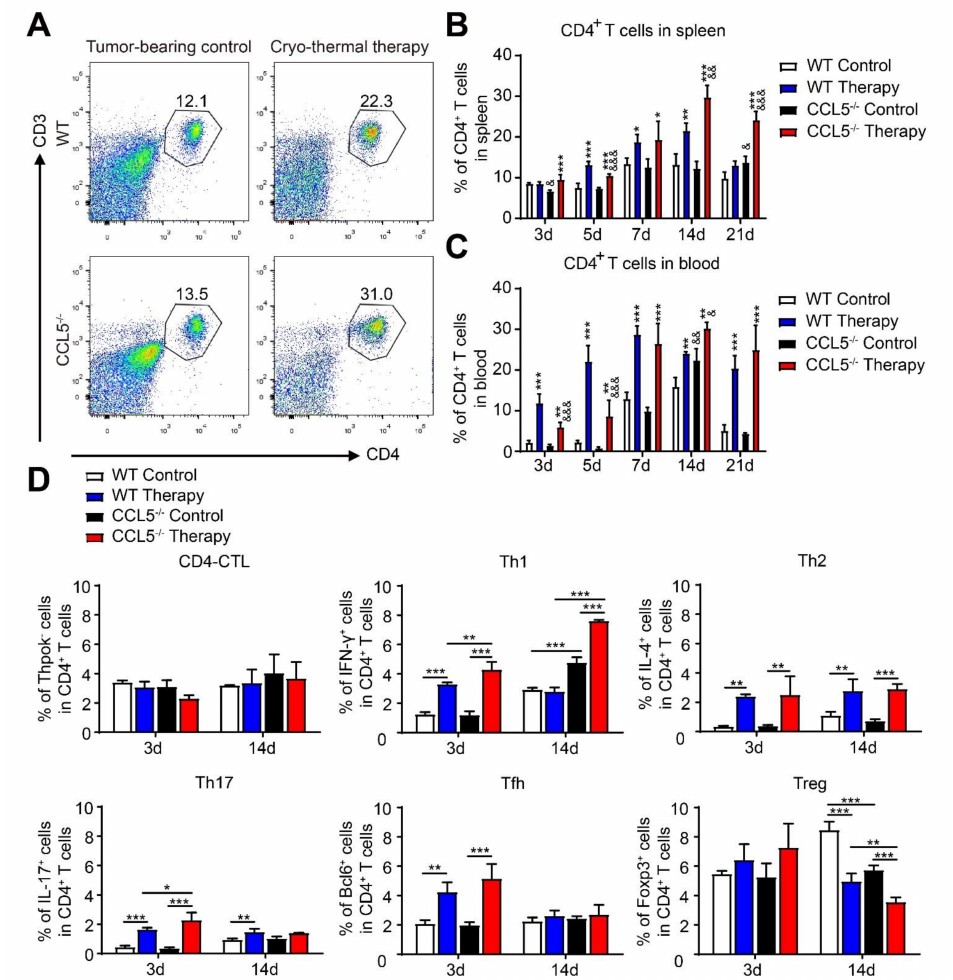
Figure 5. CCL5 deficiency strengthened cryo–thermal-induced the Th1 differentiation and inhibited Treg differentiation of CD4 + T cells. ( A ) Gating strategy for CD3 + CD4 + cells. Analysis of the CD4 + T cell proportion in the spleen ( B ) and blood ( C ) was performed at indicated time points (3, 5, 7, 14 and 21 d after therapy). ( D ) The percentages of CD4 + T cell subsets after therapy were detected with FACS. n = 4 per, mean ± SD. The data of FACS were analyzed with FlowJo 7. * p < 0.05; ** p < 0.01; *** p < 0.001, compared to WT tumor-bearing control or CCL5 − / − tumor-bearing control. & p < 0.05; && p < 0.01; &&& p < 0.001, compared to WT